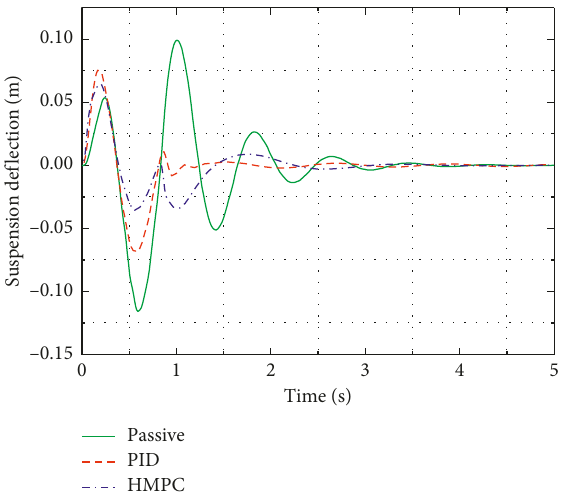
Figure 6: Suspension deflection under bump input.